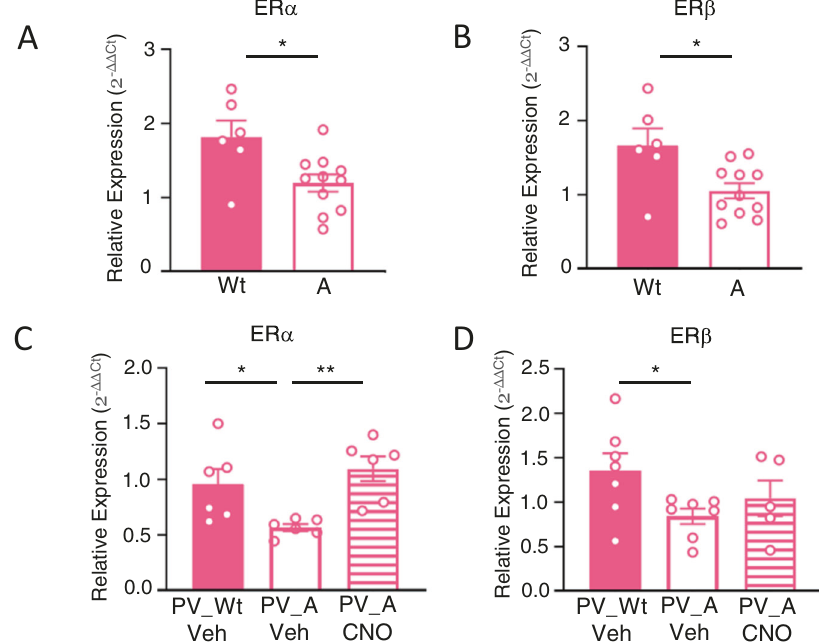
Fig. 5 Chemogenetic activation of inhibitory PV-IN in Ambra1 + / − females normalizes hippocampal mRNA ERs. A, B Histogram reports the relative expression (2- ΔΔ Ct) of estrogen receptors α (ERs α ) and β (ERs β ) in the hippocampus of Wt and Ambra1 + / − females. Baseline levels of ER α and β are signi fi cantly decreased in Ambra1 + / − females compared to Wt females. (Wt ( N = 6), A ( N = 11), for ER α : t (15) = 2.76, p = 0.0145; for ER β : t (15) = 2.746, p = 0.015). C, D Histogram reports the relative expression (2- ΔΔ Ct) of estrogen receptors α (ER α ) and β (ER β ) in the hippocampus of PV_Wt/Veh females and PV_A females injected with Veh or CNO. ER α and β levels are decreased in PV_Ambra1 + / − compared to PV_Wt females. C ER α de fi cit is signi fi cantly rescued in PV_A/CNO females, whereas no differences in ( D ) ER β level are found in PV_A/CNO females, as compared to their vehicle counterpart. [For ER α : PV_Wt/Veh ( N = 6), PV_A/Veh ( N = 6) and PV_A/CNO ( N = 6); F (2,15) = 6.96, p = 0.007; PV_Wt/Veh vs PV_A/Veh p = 0.05, PV_A/Veh vs PV_A/CNO p = 0.007. For ER β : PV_Wt/Veh ( N = 7), PV_A/Veh ( N = 7) and PV_A/CNO ( N = 5); F (2,16) = 2.761, p = 0.09; PV_Wt/Veh vs PV_A/Veh: t (12) = 2.410, p = 0.032; PV_A/Veh vs PV_A/CNO: t (10) = 1.04, p = 0.32)]. * p < 0.05, ** p <